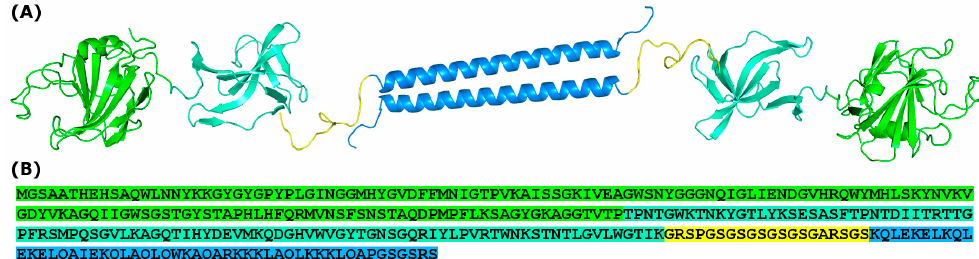
Figure 1. 3D model and amino acid sequence of Lst-HDD. ( A ) A theoretical model of Lst-HDD homodimer. Lysostaphin catalytic domain is colored green, lysostaphin peptidoglycan-binding domain is colored cyan, dimerization domain is colored blue and spacer is colored yellow. The model was constructed in PyMOL (Schrödinger LLC, USA) based on PDB entry 4LXC. ( B ) The amino acid sequence of Lst-HDD. The color scheme as in ( A ).